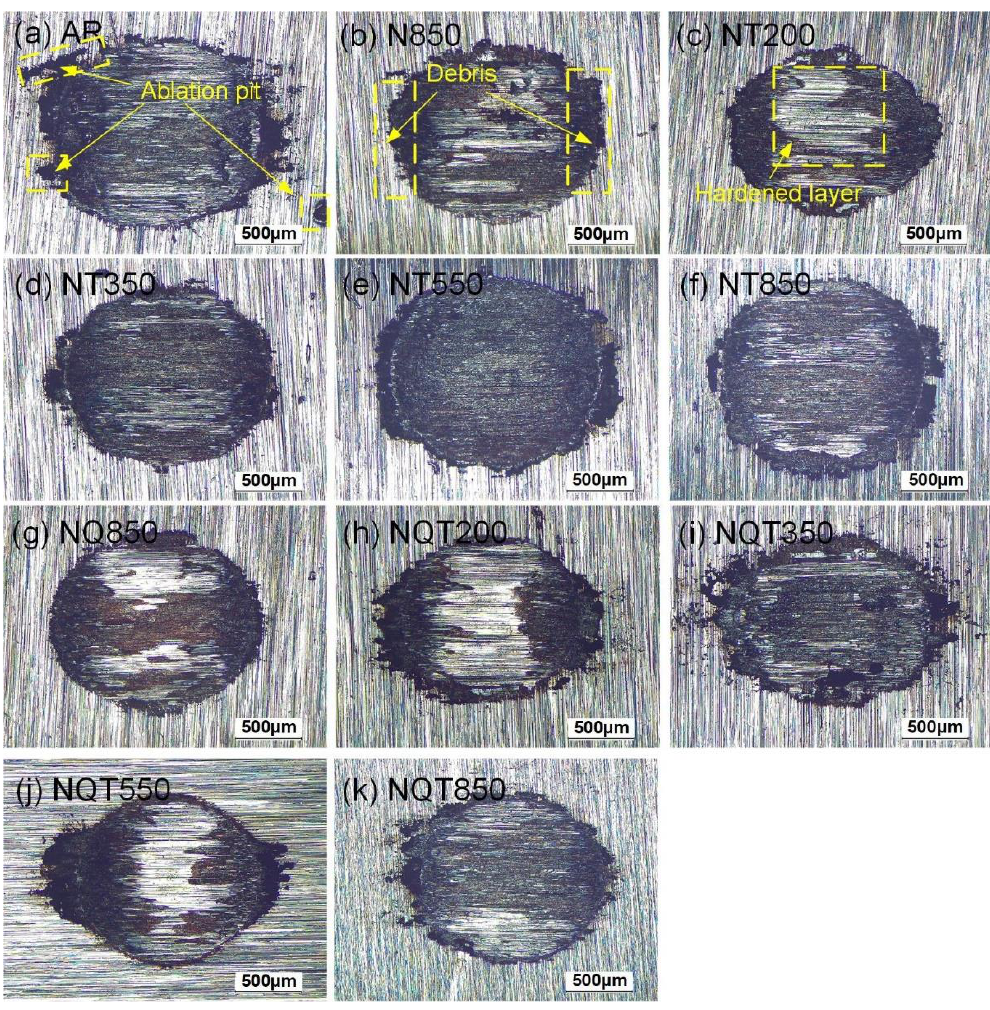
Figure 5. Optical morphologies of worn surface under different tempering states: ( a ) AR state, ( b ) N850, ( c ) NT200, ( d ) NT350, ( e ) NT550, ( f ) NT850, ( g ) NQ850, ( h ) NQT200, ( i ) NQT350, ( j ) NQT550 and (k) NQT850